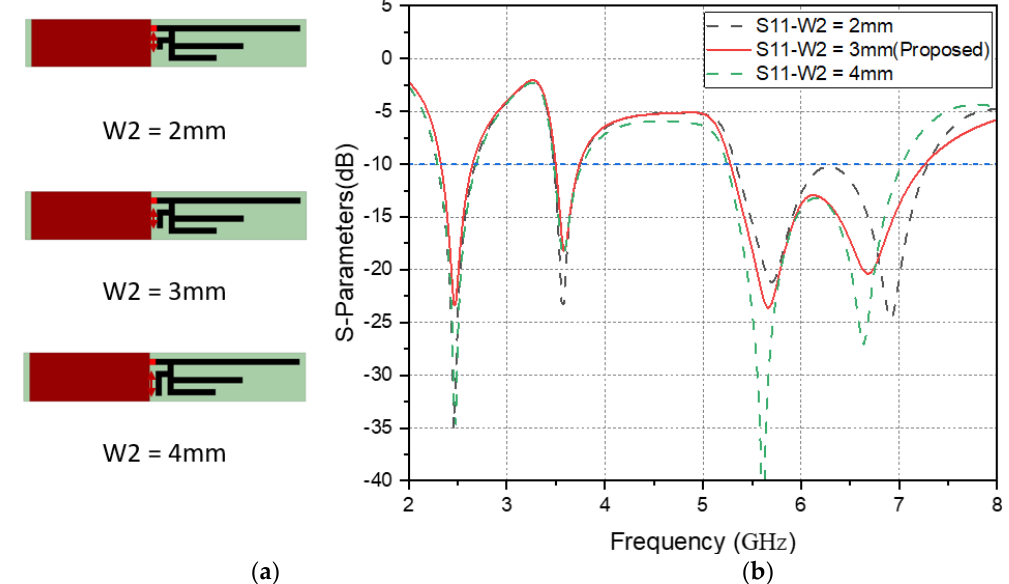
Figure 7. ( a ) Schematic diagram of W2 length variation of Ant. 1, ( b ) reflection coefficient (|S11|) of W2 length variation.